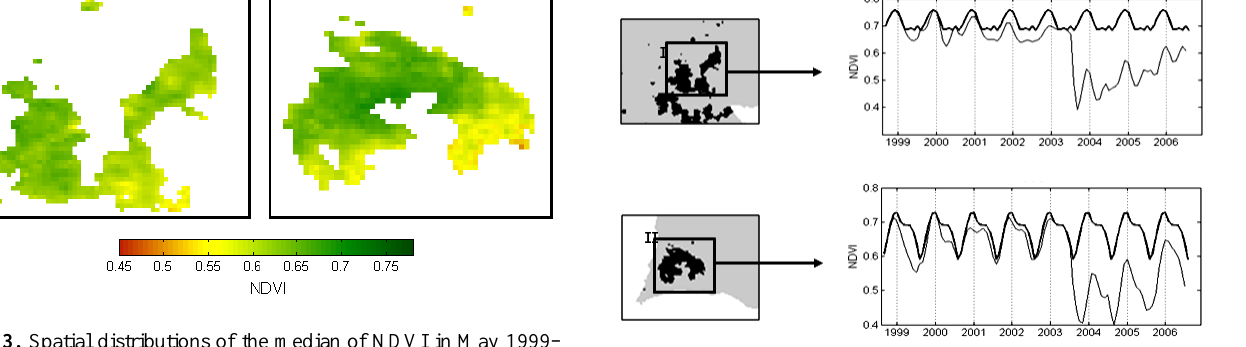
Fig. 4. Time series of NDVI (grey curves) spatially averaged over the two selected large fire scars, located in Region I (upper panel) and in Region II (lower panel), respectively. Black curves represent the Gorgeous Years (GY) of vegetation, given by the annual cycles of maximum NDVI for each month over the considered